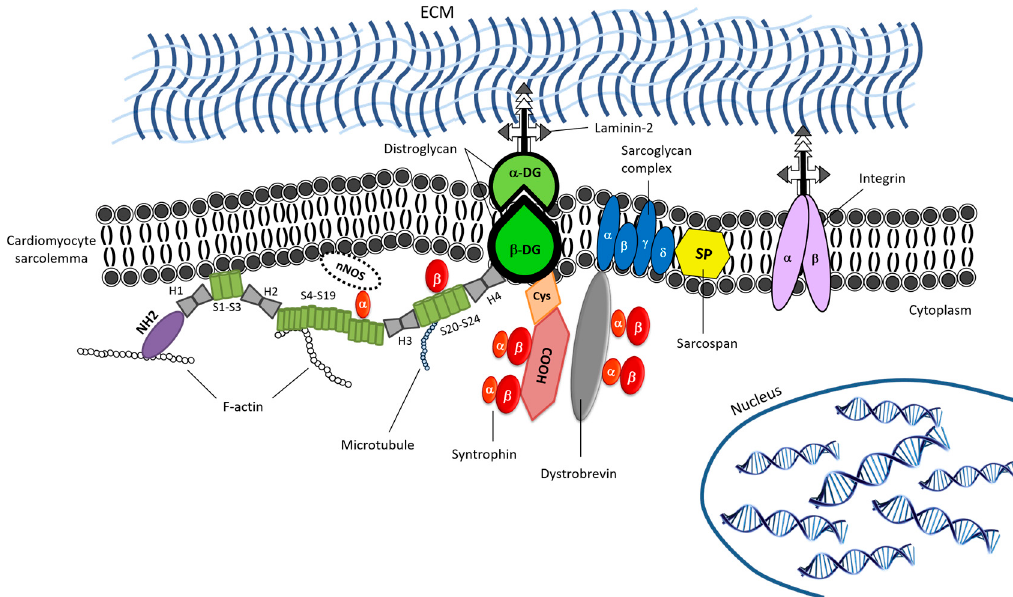
Figure 1. Schematic representation of the dystrophin glycoprotein complex (DGC). The dystrophin glycoprotein complex (DGC) is composed of four different sections according to their localization on the plasma membrane: (i) α -dystroglycan on the extracellular surface acts as a receptor for the intermediate filament laminin that works together with the DGC to maintain cell-basal lamina adhesion; (ii) in the transmembrane region, α -dystroglycan binds to β -dystroglycan and sarcoglycan proteins ( α , β , γ , δ ); (iii) within the sarcolemma, sarcospan joins the sarcoglycan complex to integrin proteins; (iv) β -dystroglycan and dystrophin anchor the sarcolemma to the intracellular domain of the DGC, which stabilizes the contractile apparatus of myocytes and the remaining part of the DGC via binding to the actin network. Crucially, as a whole entity, the DGC secures the correct location of neuronal nitric oxide synthase (nNOS), an essential enzyme that produces nitric oxide (NO), which is required to modulate vascular tone among other essential cellular signaling needed to meet tissue demands.